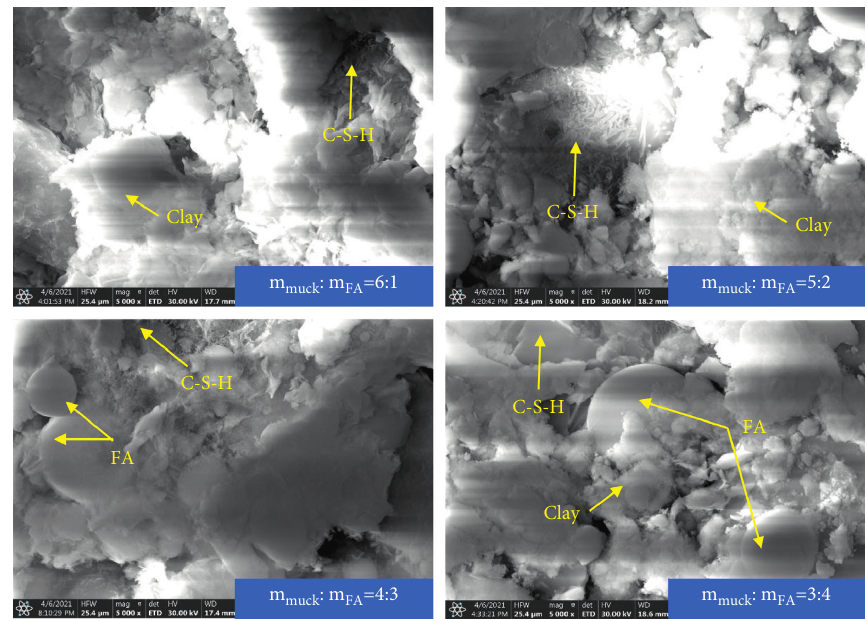
Figure 11: SEM images of nonsintered bricks with different fly ash content.